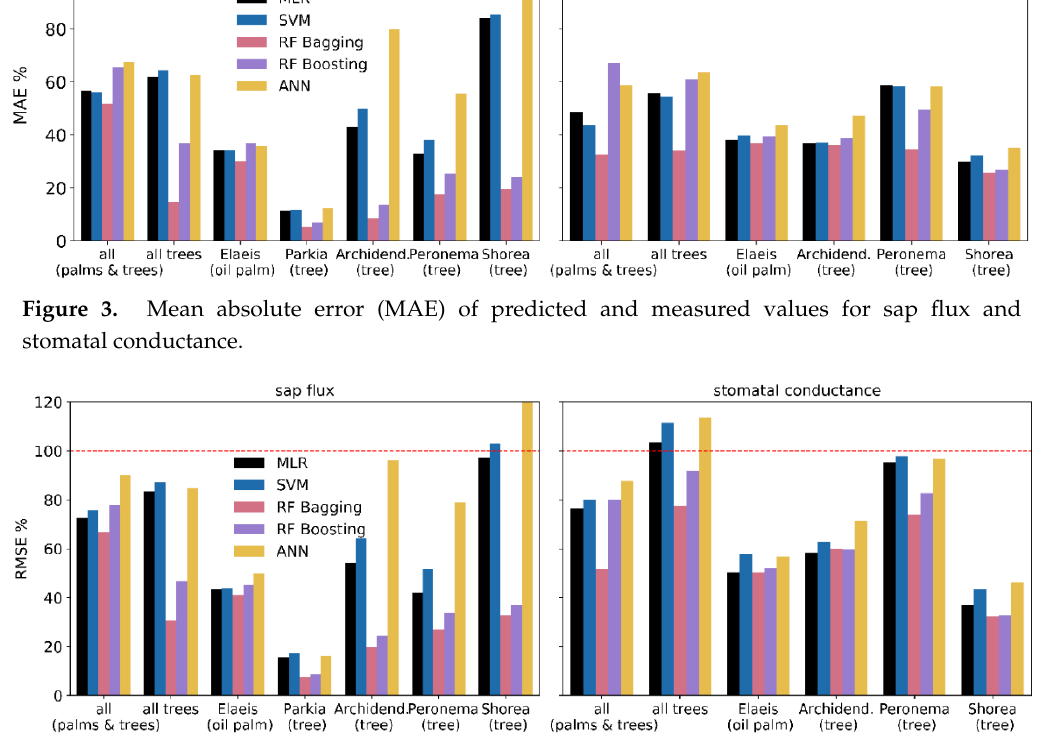
Figure 4. Root mean square error (RMSE) of predicted and measured values for sap flux and stomatal conductance.